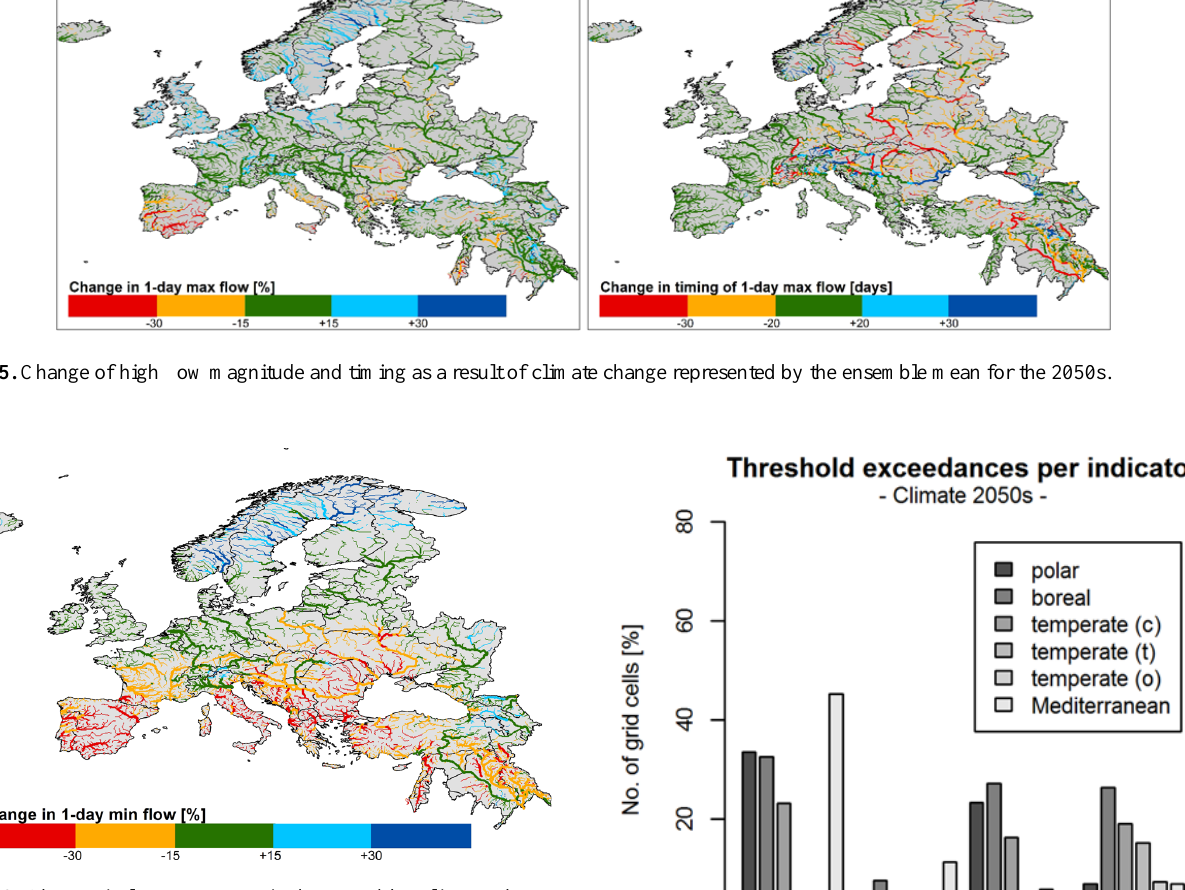
Fig. 6. Change in low flow magnitude caused by climate change represented by the ensemble mean for the 2050s.